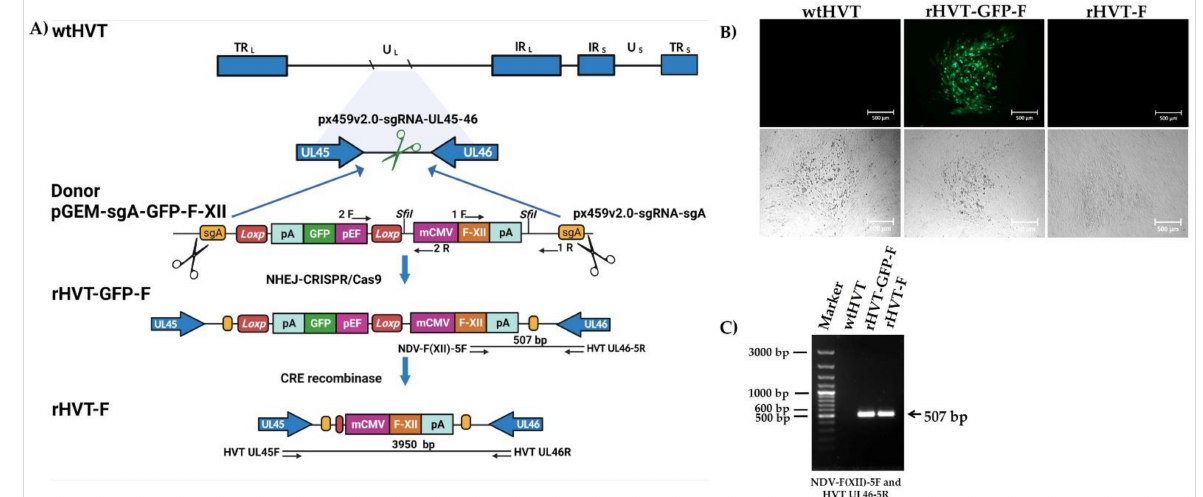
Figure 1. The strategy used for the generation of the rHVT-F virus. ( A ) The genome of the wild-type (wt) Herpesvirus of turkey (HVT) is shown with unique long (UL), unique short (US), terminal and internal repeat long (TRL/IRL), and short (TRS/IRS) regions. The single guide (sg)RNA-UL45-46 introduced double-stranded breaks (DSBs) in the intergenic region UL45–UL46 of the wtHVT genome. The scissor symbol (green) represents the sgRNA-UL45-46 targeting site in the UL45-UL46 of the wtHVT genome. The green fluorescence protein (GFP) expression cassette contains: the elongation factor promoter (pEF), the complete open reading frame (ORF) of the GFP, and poly-A signal sequence (pA); Fusion (F) expression cassette contains: murine cytomegalovirus promoter (mCMV), the ORF of the F protein of Newcastle disease virus (NDV), and pA. The GFP and F expression cassettes from the donor plasmid were flanked with sg-A target sites to introduce the desired cleavage for its release and integration using the non-homologous end joining (NHEJ)—clustered regularly interspaced short palindromic repeat (CRISPR) -associated 9 (CRISPR/Cas9) strategy into the genome of wtHVT. The scissor symbol (blacks) represents the sgRNA-sgA targeting sites in the donor plasmid. The GFP reporter expression cassette was excised from rHVT-GFP-F using the Cre-loxP System and the new recombinant HVT was named rHVT-F. The fragments amplified by polymerase chain reaction (PCR) using the primers 1F/1R and 2F/2R showed the correct insertion of the F expression cassette into plasmid pGEM-sgA-GFP-F-XII. The junction primers NDV-F(XII)-5F/HVT UL46-5R (507 bp, base pairs = bp) showed the insertion of the F expression cassette at the correct locus into the genome rHVT-GPF-F and rHVT-F (after excision of the GFP reporter cassette). The primers HVT UL45F/HVT UL46R (3950 bp) showed the presence of the complete NDV F expression cassette in the genome at the correct locus of rHVT-F. This drawing was created with BioRender.com (Not drawn to scale). ( B ) Comparison of plaque morphology between rHVT-GFP-F, rHVT-F, and wtHVT. The plaque morphology of infected chicken embryo fibroblast (CEF) cells, induced by the rHVT-GFP-F, rHVT- F, and wtHVT viruses, was observed by fluorescence (top panel) and bright-field (bottom panel) microscopy: 100 × magnification, and all scale bars represent 500 µ m. ( C ) The presence of the NDV F expression cassette in the HVT genome was verified by PCR using the primers NDV-F(XII)-5F and HVT UL46-5R, as shown in ( A ) in both rHVT-GFP-F and rHVT-F,